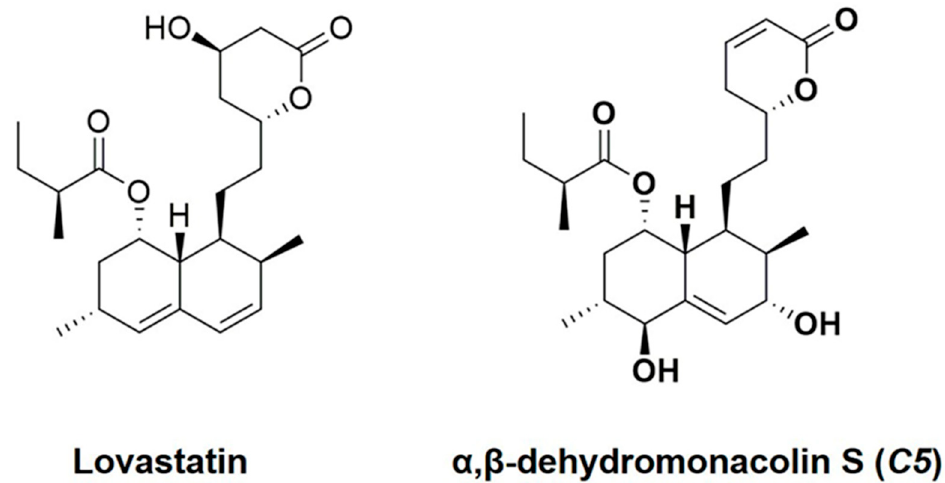
Figure 1. Structures of lovastatin (LO) and α , β -dehydromonacolin S ( C5 ).